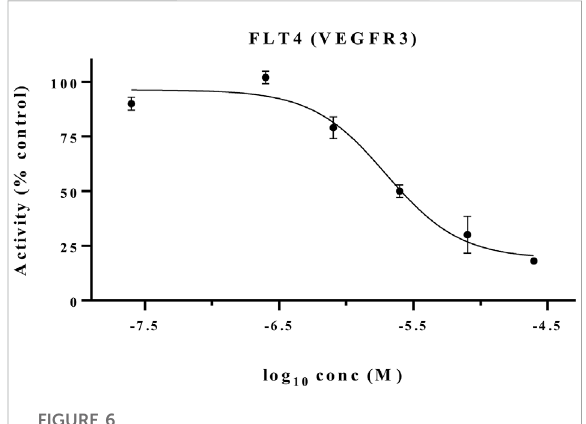
FIGURE 6 FLT4 (VEGFR3) kinase inhibitory activity of CM9 . Kinase inhibition was examined by a Radiometric Assays. CM9 inhibited FLT4 (VEGFR3) kinase activity with an IC 50 of 5.01 µM.